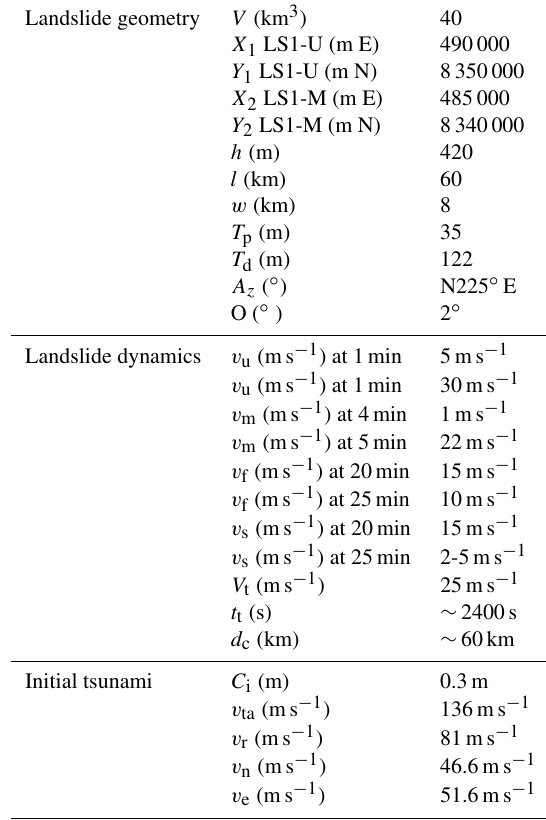
Table 1. Storfjorden LS-1 geometry and mechanical characteris- tics. The inputs for the model are related to the landslide geometry: the total volume ( V ), the longitude and latitude of the submarine landslide relative to the LS1-U slope area ( X 1 , Y 1 ) and the LS1-M slope area ( X 2 , Y 2 ), the initial depth ( h ) before the slope failure, the length ( l ) (long axis) and width ( w ) (small axis), the maximum thickness in the proximal and distal areas ( T p and T d , respectively), the mean azimuth direction of the landslide ( A z ), and the mean slope gradient ( O ). The outputs of the model are related to the land- slide dynamic: velocities to the landslide in the upper slope ( v u ) and the landslide located in the mid slope ( v m ), sliding sediment in the frontal area ( v f ), sliding sediment in the sides ( v d ), total veloc- ity ( V t ), terminal duration ( t t ), and characteristic distance ( d c ). The outputs related to initial tsunamis: wave crest ( C i ) tsunami velocity at 1900m depth ( v ts ), tsunami wave velocity during refraction ( v r ), tsunami wave velocity toward the north ( v n ) and tsunami wave ve- locity toward the southeast ( v e ). LS1-U: Storfjorden landslide upper slope; LS1-M: Storfjorden landslide mid slope. Landslide